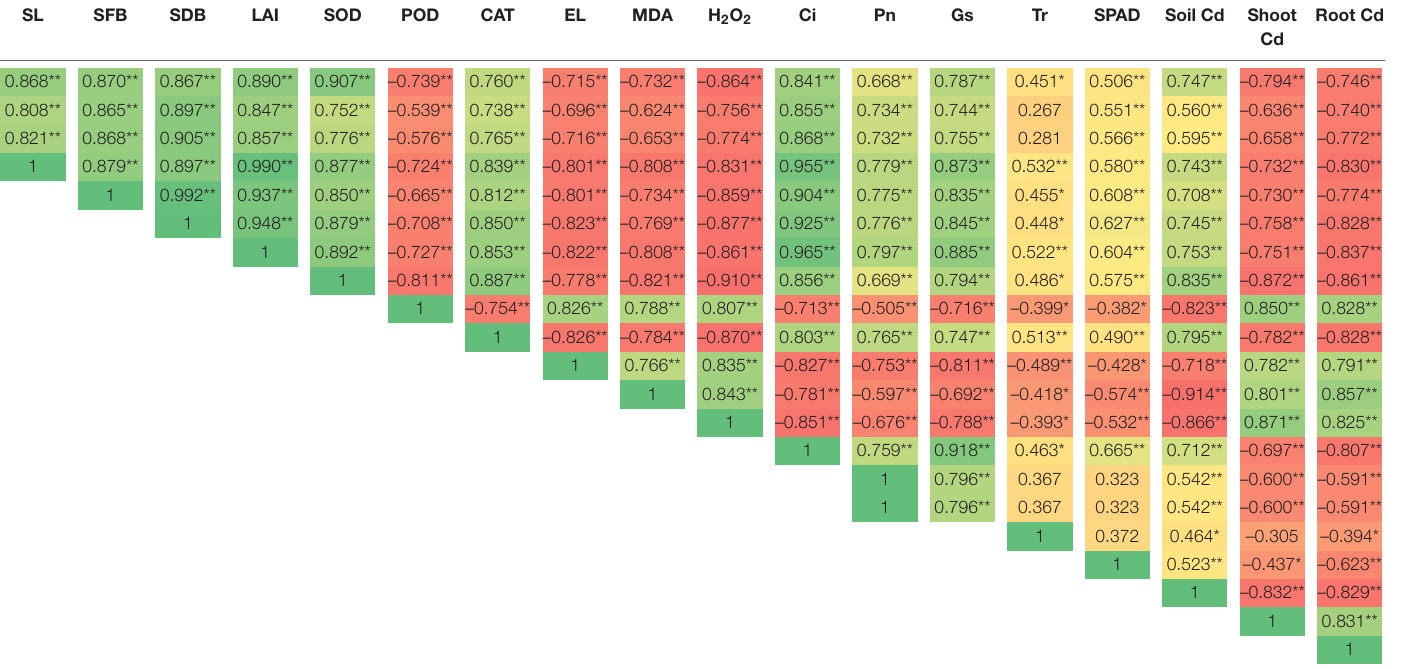
**represents that results are significant at p < 0.01; *represents that results are significant at p < 0.05; RL, total root length; RFB, root fresh biomass; RDB, root dry biomass; SL, shoot length; SFB, shoot fresh biomass; SDB, shoot dry biomass; LAI, leaf area index; SOD, superoxide dismutase in leaves; POD, peroxidase in leaves; CAT, catalase in leaves; EL, electrolyte leakage in leaves; MDA, malondialdehyde; H 2 O 2 ,